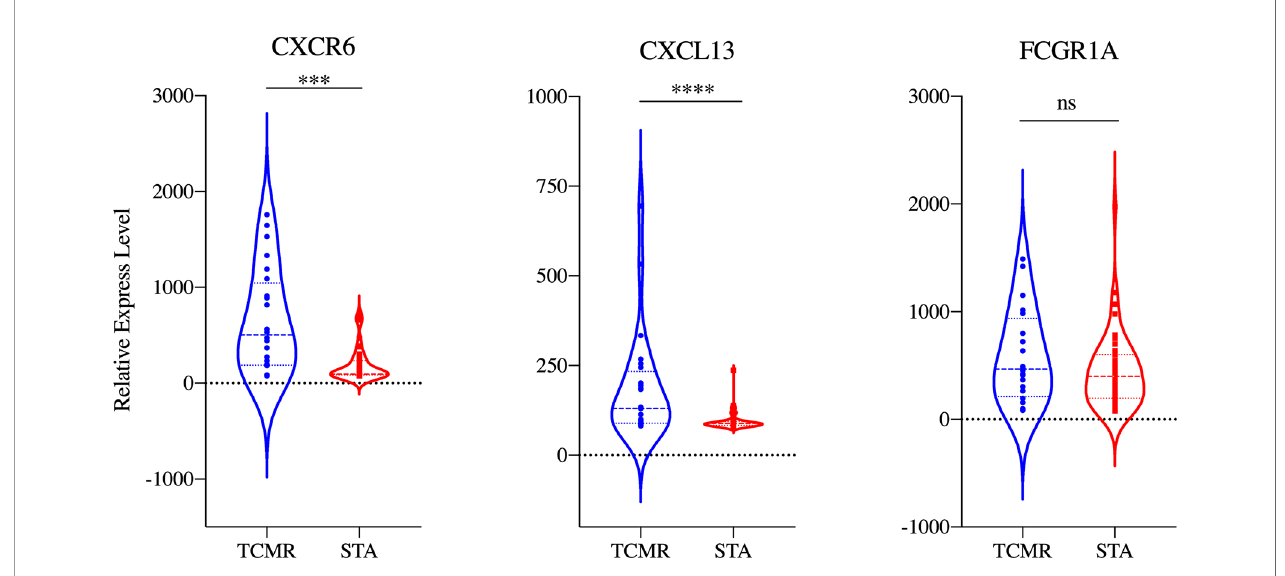
FIGURE 3 | Validation of the expression of the three diagnostic biomarkers in the GSE69677 dataset. *** p < 0.001; **** p < 0.0001.